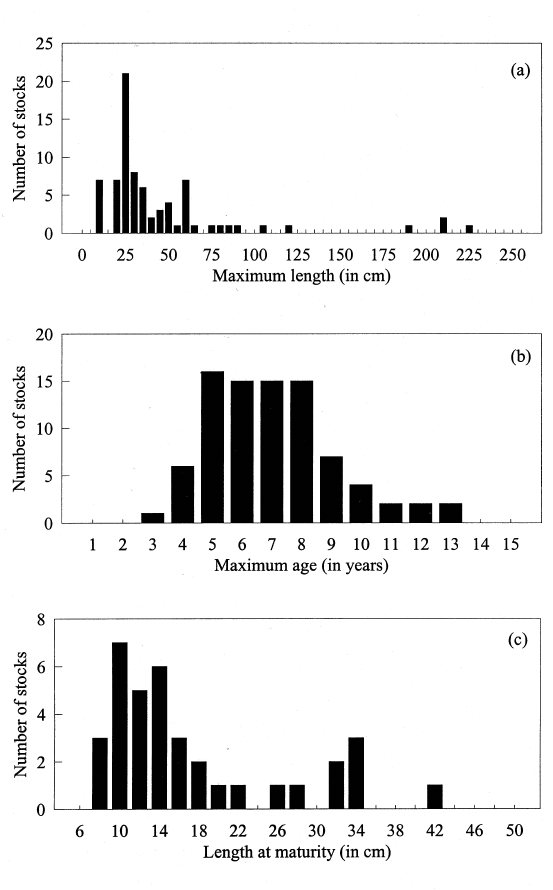
Fig. 1. (a) Maximum length, (b) maximum age and (c) length at maturity for a variety of fish stocks in Hellenic